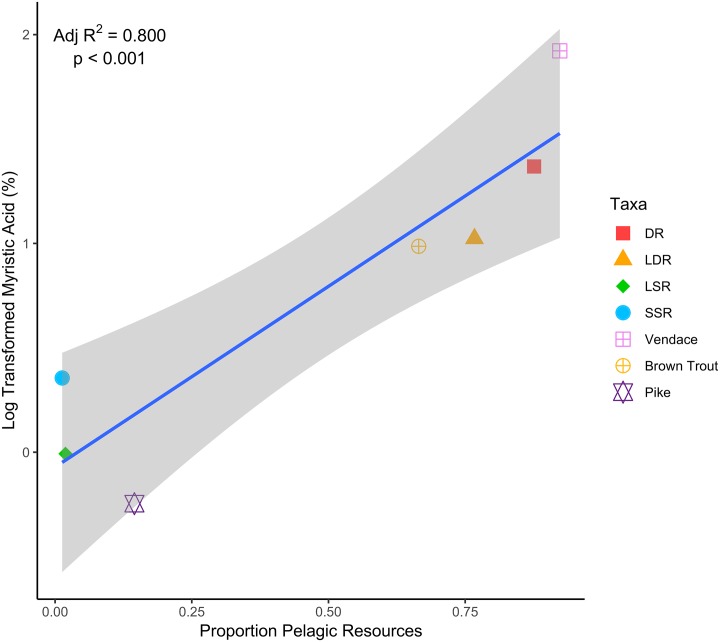
Relationship between log-transformed myristic acid concentration (%) and mean pelagic reliance (estimated from SIAR model based on δ13C, δ15N and diet data) across all fish taxa.DR = densely-rakered whitefish, LDR = large densely-rakered whitefish, LSR = large sparsely-rakered whitefish, SSR = small sparsely-rakered whitefish.